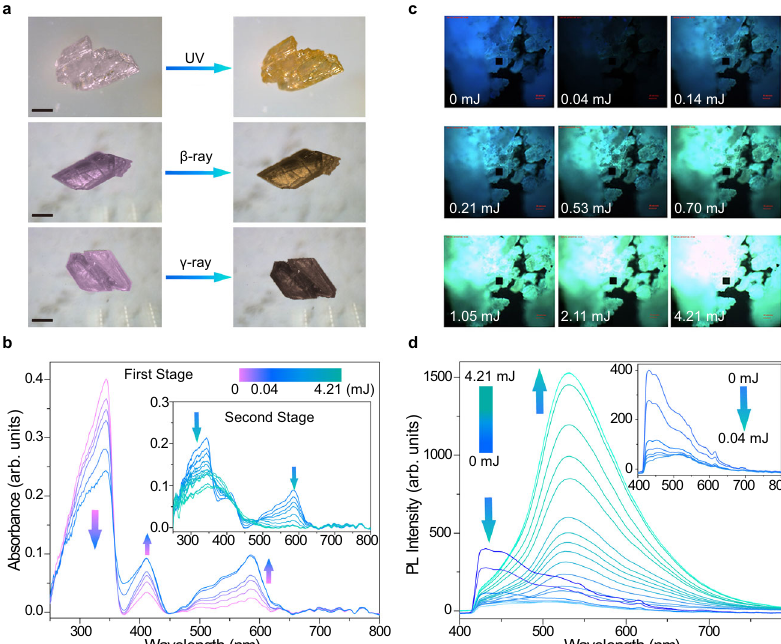
Fig. 2 Dual-module photochromism of Th-SINAP-100. a Photochromism of Th-SINAP-100 upon UV-, β -ray, and γ -ray irradiation. The black scale bars in photographs represent 200 μ m in length. b Evolution of the solid-state UV-Vis absorption spectra of Th-SINAP-100 crystal after exposure to 0 – 0.04 mJ UV irradiation doses ( λ ex = 365 nm, 2 mW) at 25 °C. Inset: solid-state UV-Vis absorption spectra of Th-SINAP-100 crystal after exposure to 0.04 – 4.21 mJ UV irradiation dose. The UV-Vis spectra were collected on a crystal of Th-SINAP-100 from 250 to 800 nm based on the average intensities of 50 scans with a scan time of 2 ms. c Snapshots of bulk Th-SINAP-100 crystals upon 365 nm UV irradiation. d Evolution of the solid-state photoluminescence (PL) spectra of Th-SINAP-100 crystal after exposure to 0 – 4.21 mJ UV irradiation doses ( λ ex = 365 nm, 2 mW) at 25 °C. Inset: PL spectra of Th-SINAP-100 after exposure to 0 – 0.04 mJ UV irradiation doses. The PL spectra were collected on a crystal of Th-SINAP-100 from 400 to 800 nm based on the average intensities of 5 scans with a scan time of 500